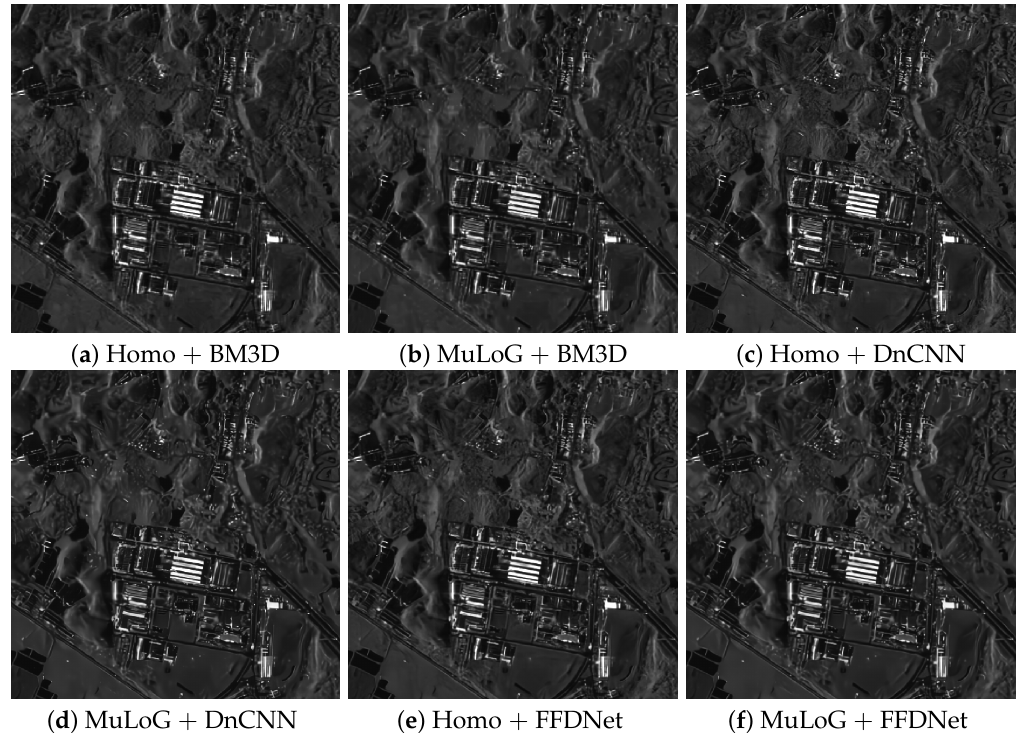
Figure 10. The denoising results for real SAR image: Data 1: ( a – f ) Homo + BM3D, MuLoG + BM3D, Homo + DnCNN, MuLoG + DnCNN, Homo + FFDNet, and MuLoG + FFDNet,